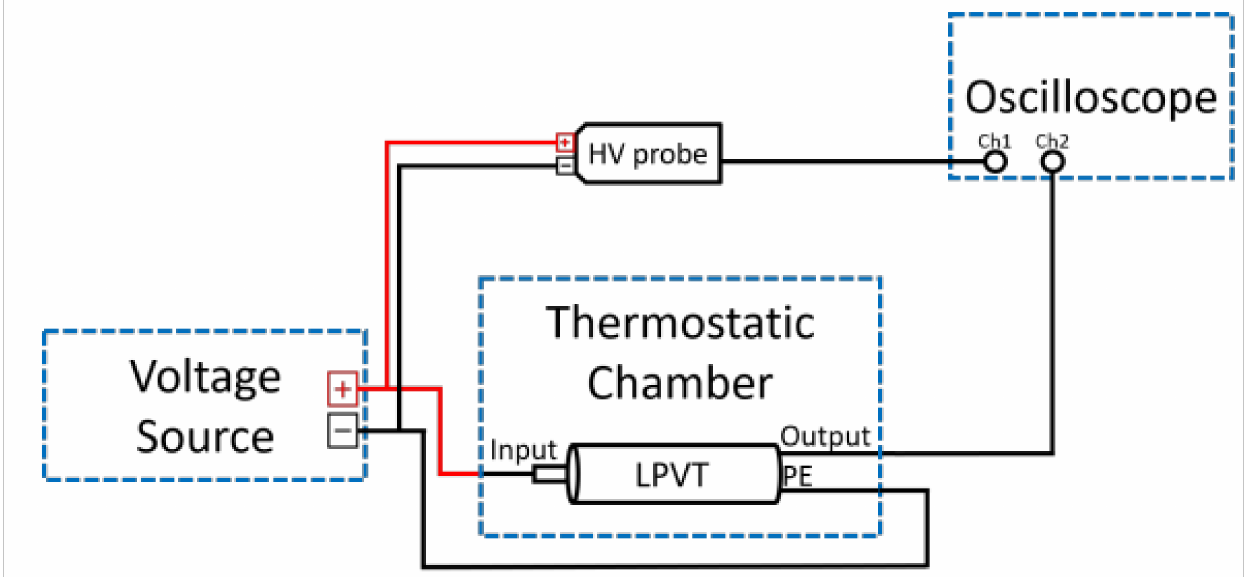
Figure 3. Transformation ratio measurement setup used for testing vs. temperature and vs.